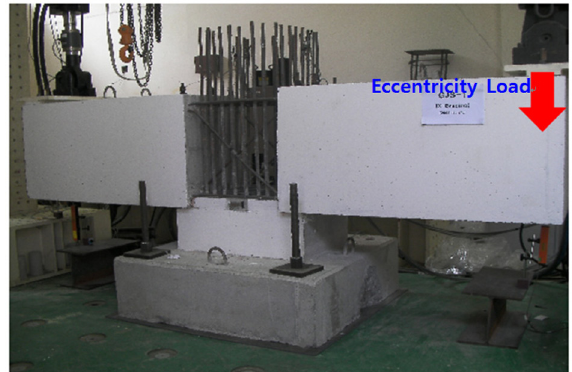
Fig. 8. View of experimental setup